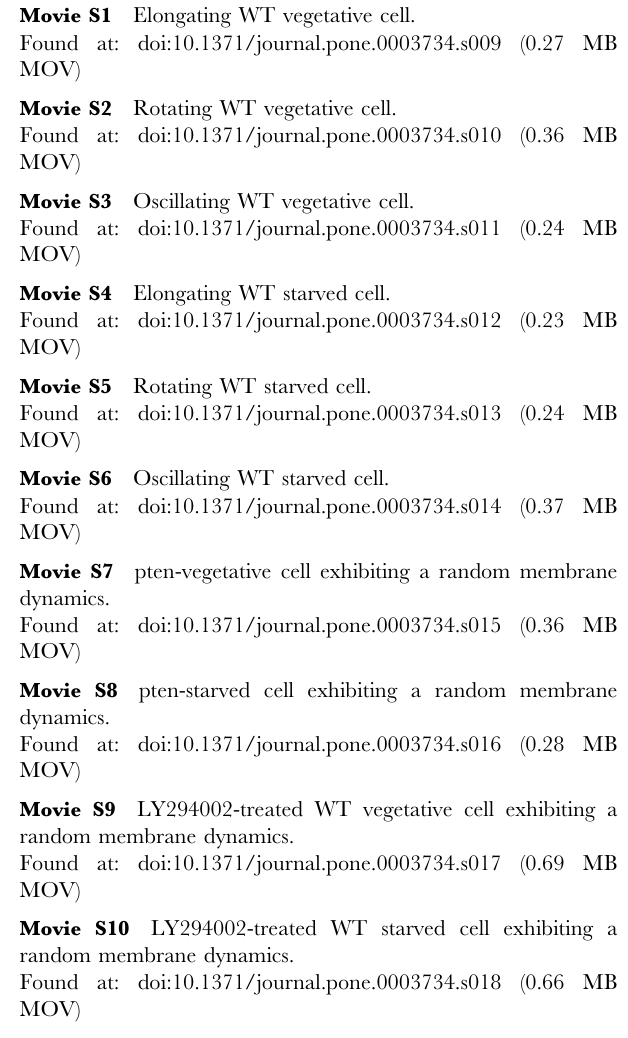
Figure S6 Act ( &theta, t ) : a reliable measure of F-actin accumu- lation. (A) We employed Act ( &theta, t ) instead of the measure of I ( r, &theta, t ) along cell membrane because F-actin accumulates nearby cell membranebut not on the edge of cell membrane (see Figure 5A). To test the reliability of Act ( &theta, t ), we compared it with the largest intensity of F-actin along a radius from centroid, Imax ( &theta, t ).